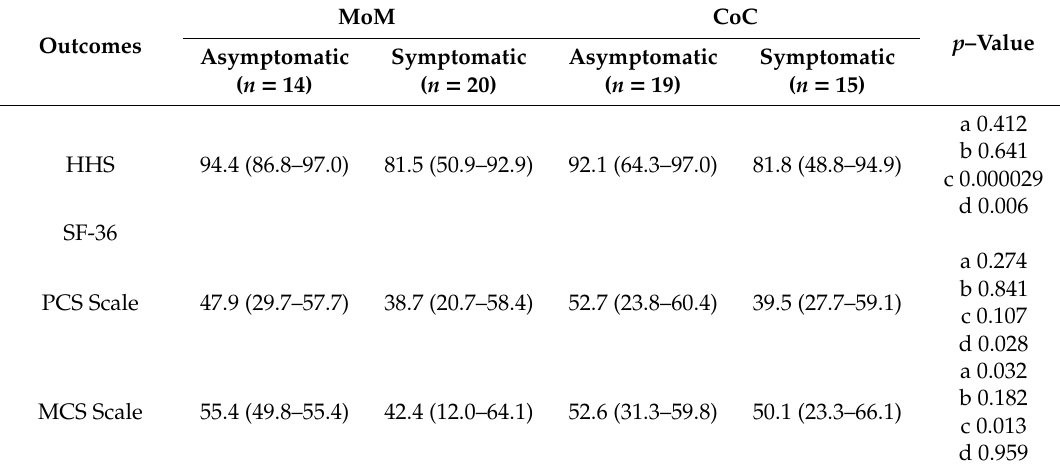
Table 6. Clinical and radiological outcomes comparing asymptomatic and symptomatic